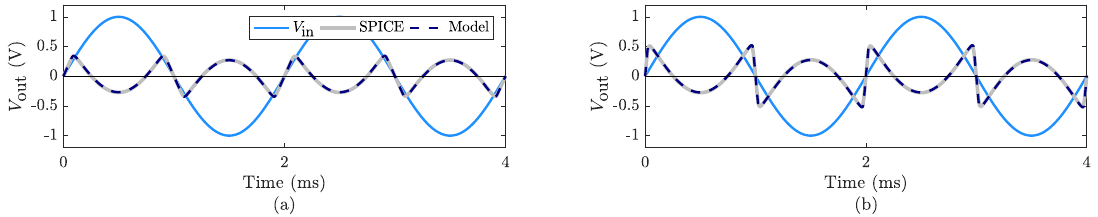
Figure 4. Time-domain view of the proposed Lockhart wavefolder model plotted against its SPICE simulation for a 500-Hz sinusoidal input (peak amplitude 1V) with load resistance: ( a ) R L = 10k Ω ; and ( b ) R L = 50k Ω